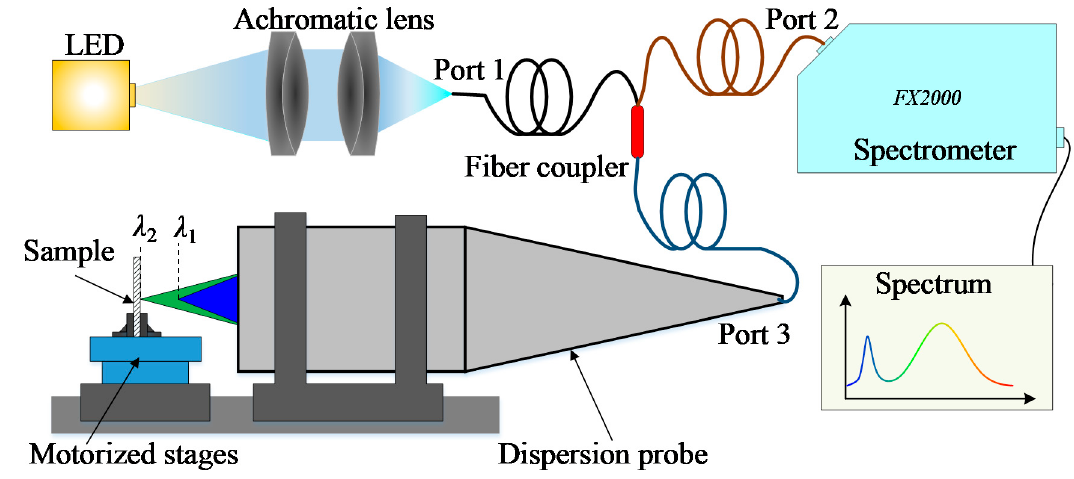
Figure 1. Schematic diagram of the chromatic confocal technology (CCT) system.